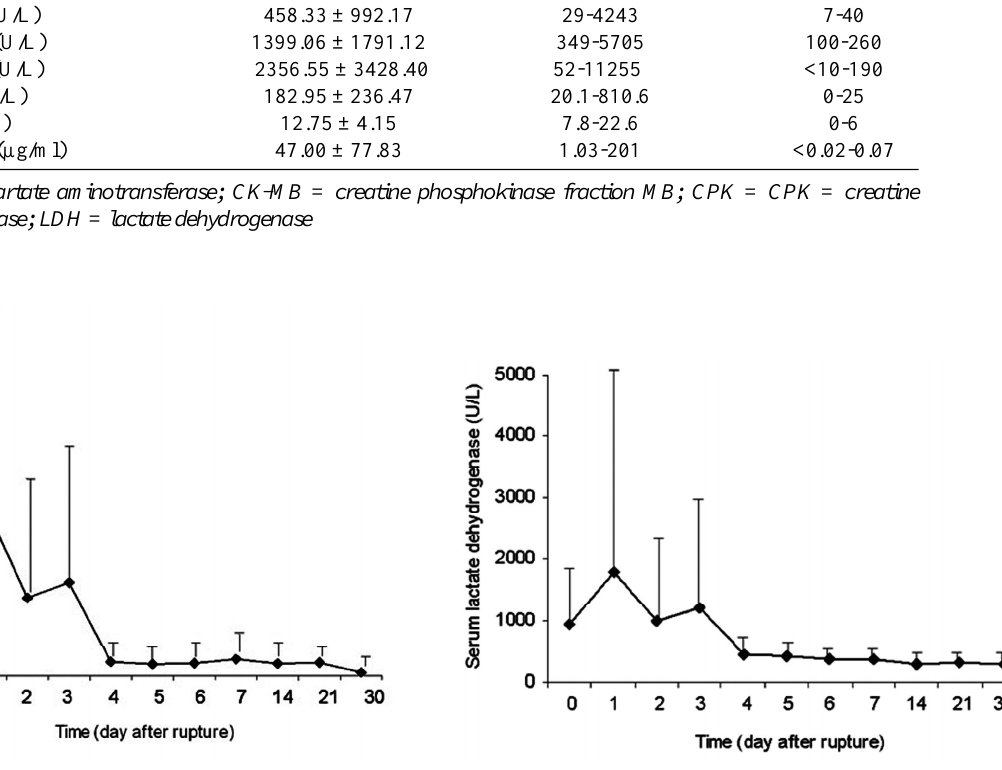
Fig. 1 - Kinetics of serum aspartate aminotransferase after myocardial rupture